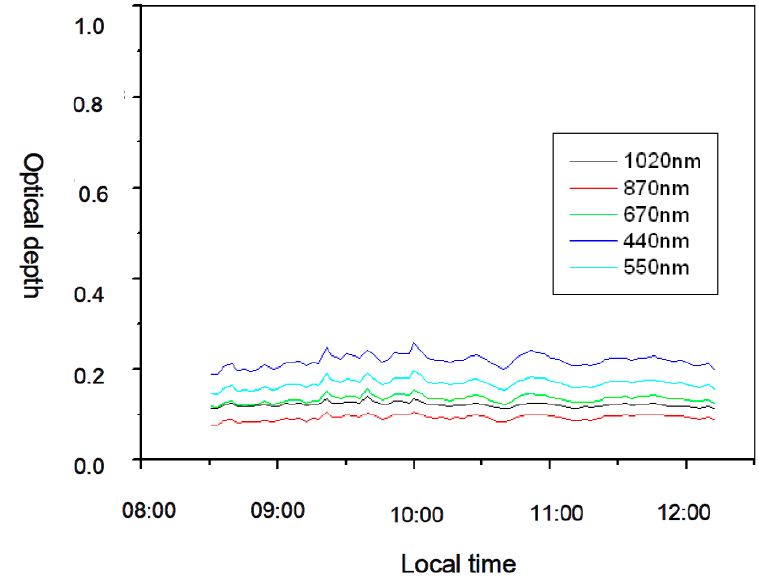
Figure 33. Aerosol optical thickness measured by CE318.